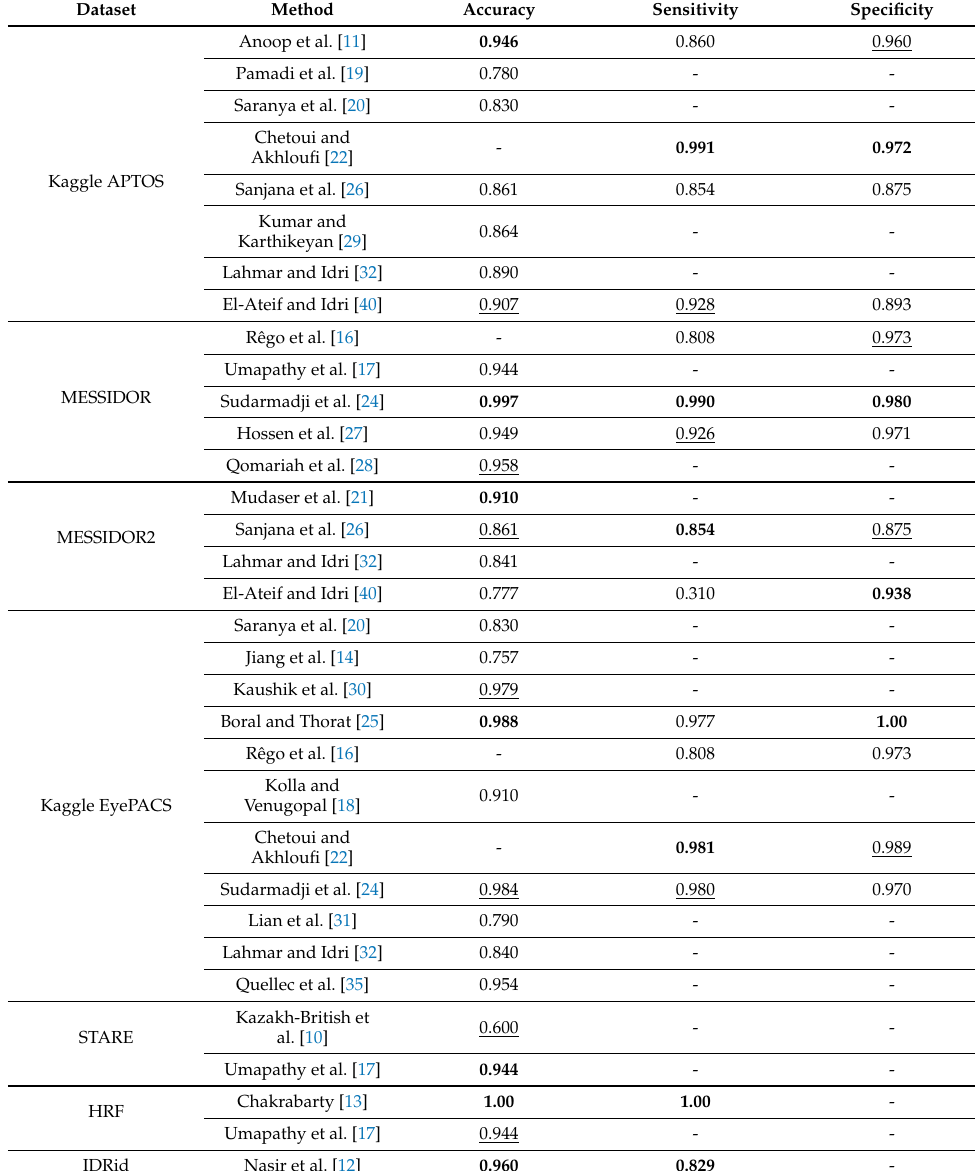
Table 3. Performance Comparison of diabetic-retinopathy-detection-based studies. The bold and underlined fonts, respectively, represent first and second